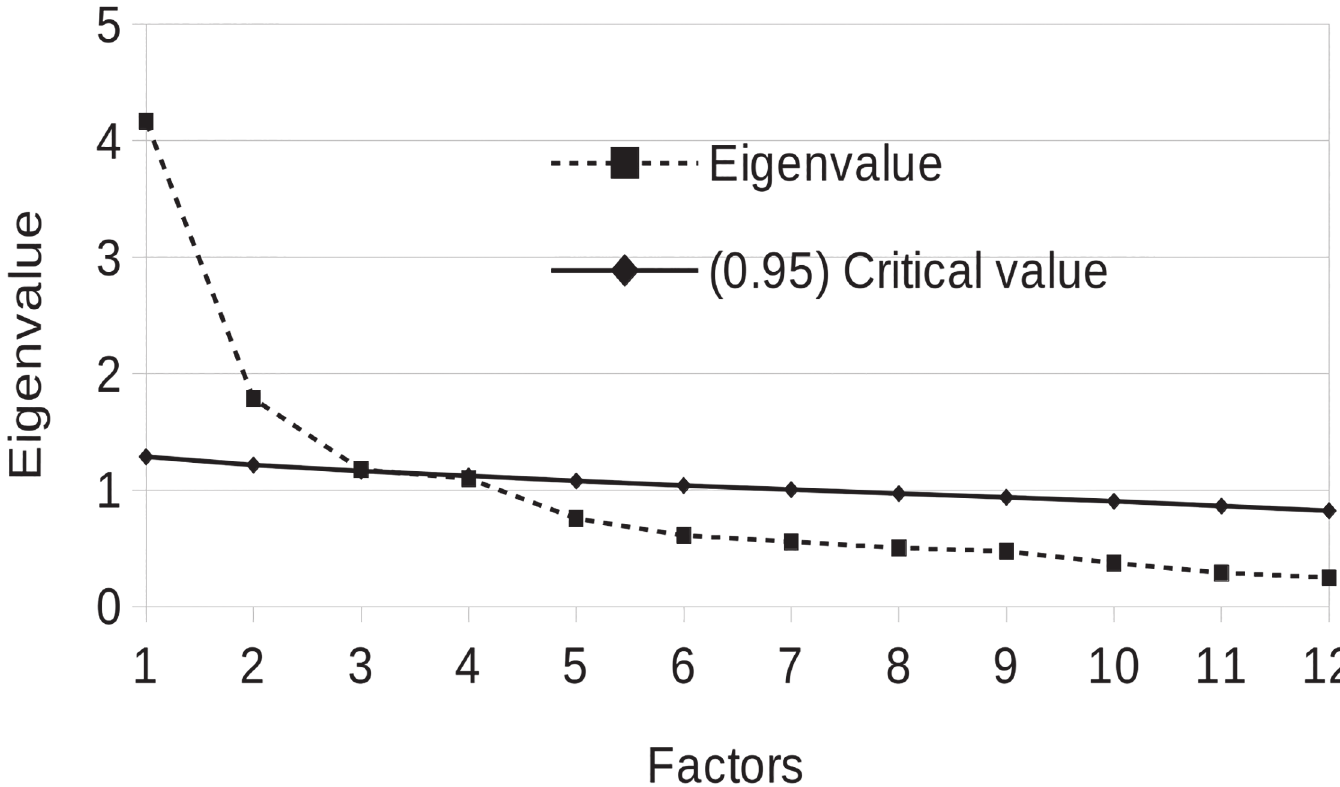
Fig 3. Scree plot of PCA involving the AQ (total result) and FCB-TI and EAS-TS PCA, and critical values of parallel analysis for the determination of significant eigenvalues.